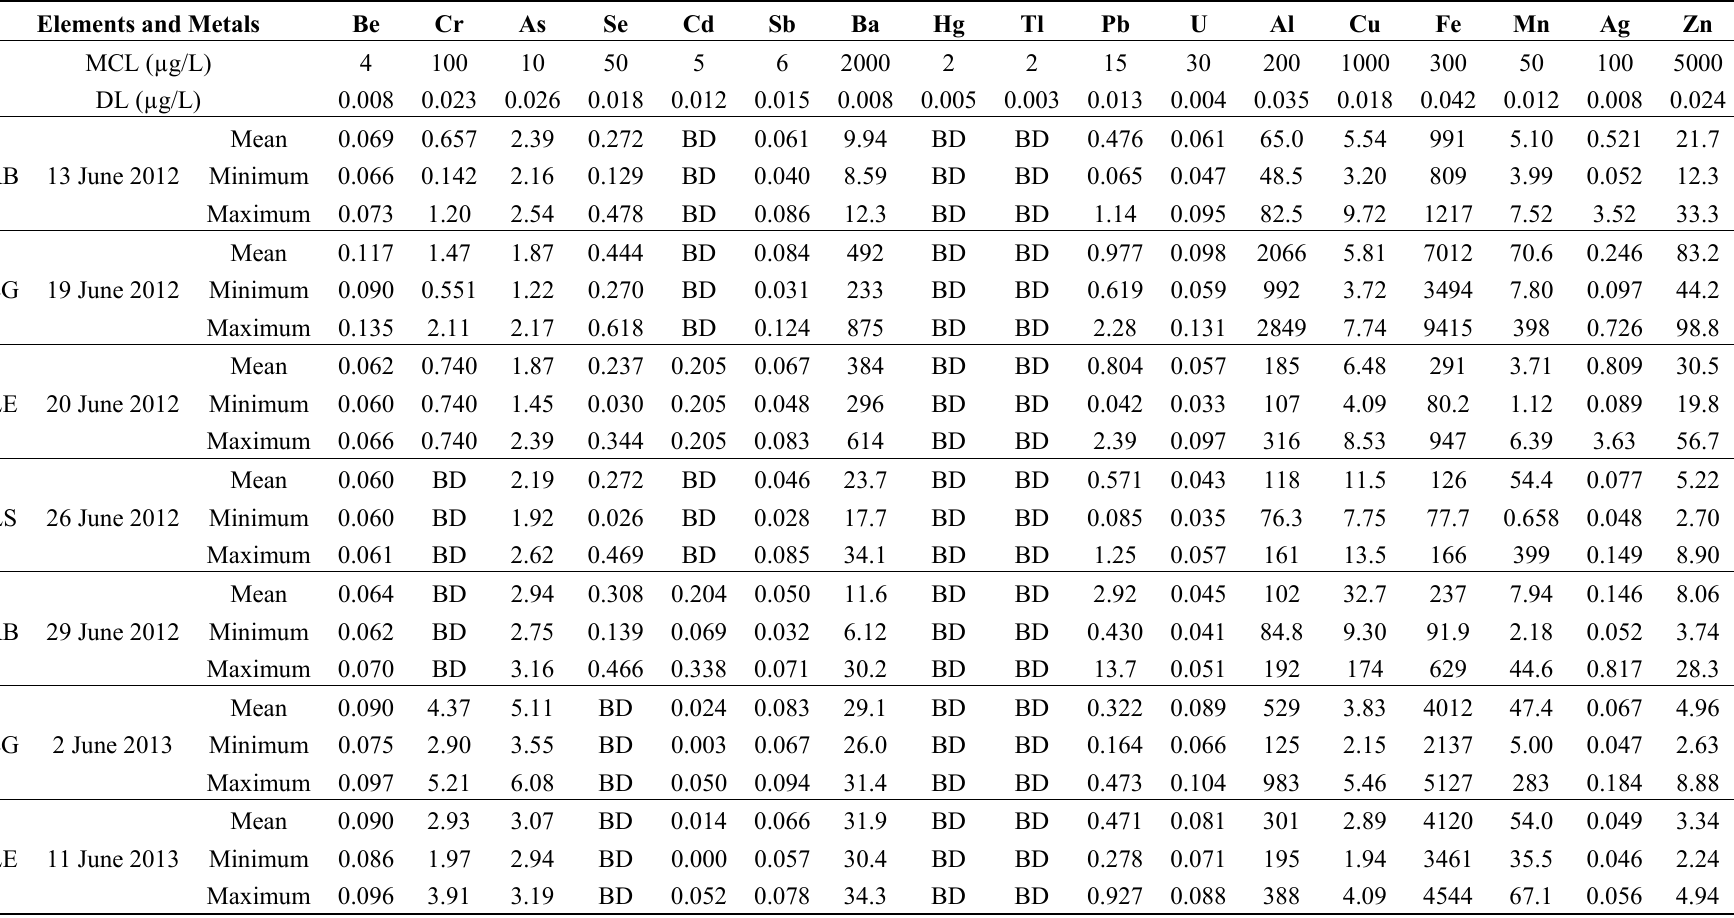
Table 1. Mean, minimum, and maximum concentration of selected trace elements and heavy metals measured at 12 sites in each of the lakes (RB = Ross Barnett Reservoir, LG = Lake Grenada, LE = Lake Enid, and LS = Lake Sardis) given in µg/L with EPA recommended maximum contaminant level (MCL) in µg/L, detection limits (DL) in µg/L, and values highlighted for the elements that exceeded the MCLs indicated (BD—below detection